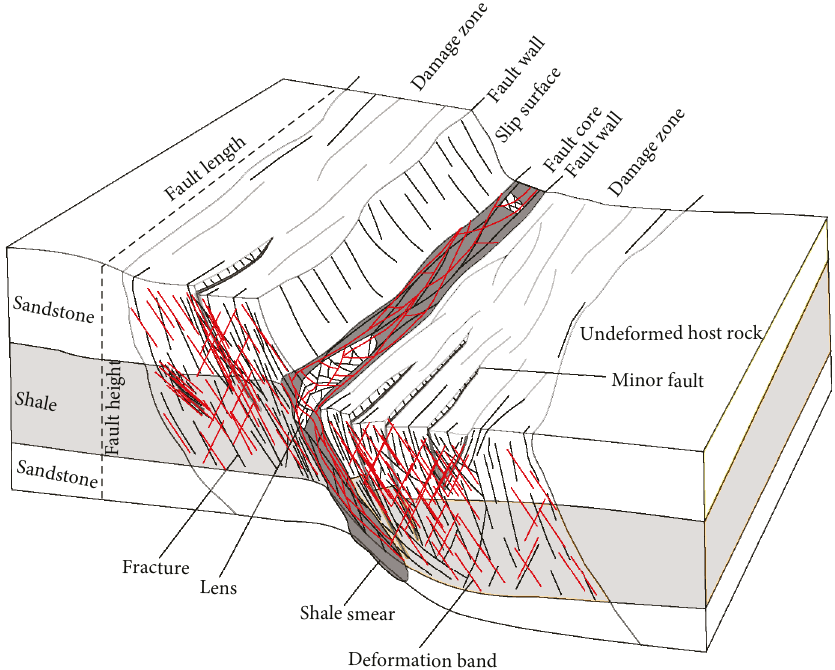
Figure 1: An illustration of a normal fault and its geometric attributes. Boundaries of fault core and damage zone and their internal structures are